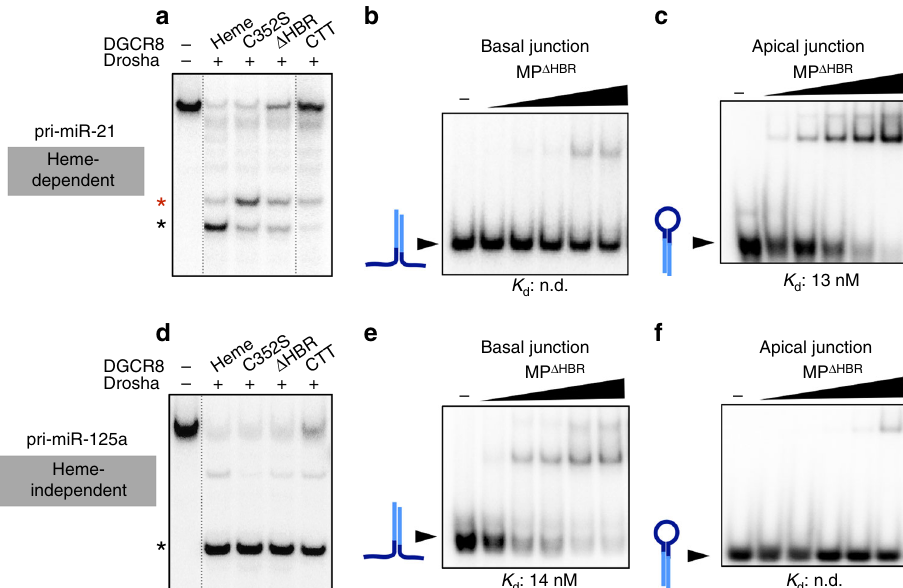
Fig. 3 Heme enables DGCR8 to guide Drosha to the correct junction. a 5 ′ end-labeled in vitro processing assays of pri-miR-21, using MP Heme (130 nM), MP C352S (130 nM), MP Δ HBR (260 nM), and MP CTT (1.04 μ M). Correct (black asterisk) and incorrect (red asterisk) products are indicated. DGCR8 Δ HBR lacks the HBR but contains the tandem dsRBDs and C-terminal tail. Deletion of HBR and dsRBDs yields the C-terminal tail (DGCR8 CTT ). b , c EMSAs comparing binding af fi nities of MP Δ HBR to basal b and apical c junctions of pri-miR-21. Schematic diagrams of the RNA are shown next to free RNA bands (arrow), with mature sequence shown in light blue. The basal junction RNAs are annealed RNA duplexes lacking the terminal loop. The apical junction RNAs are the pre-miR fragments. Protein concentrations are (left to right): 3.33, 6.67, 10, 13.32, and 16.67 nM. d 5 ′ end-labeled in vitro processing assays of pri-miR-125a, similar to a . e , f EMSAs similar to b and c , for